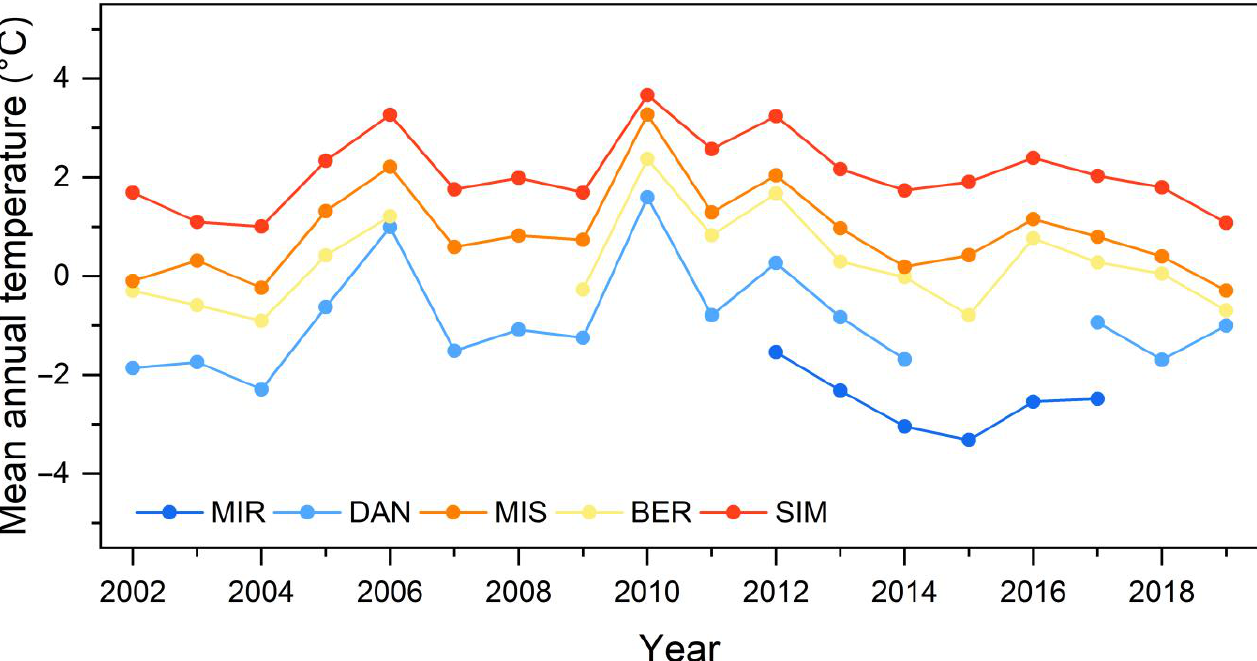
Figure 2. Mean annual temperature recorded at the five permanent sites in the boreal forest of Quebec, Canada.